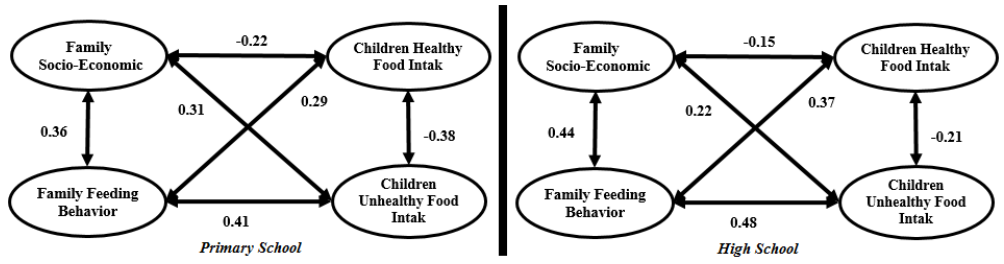
Figure 9. Full measurement model.